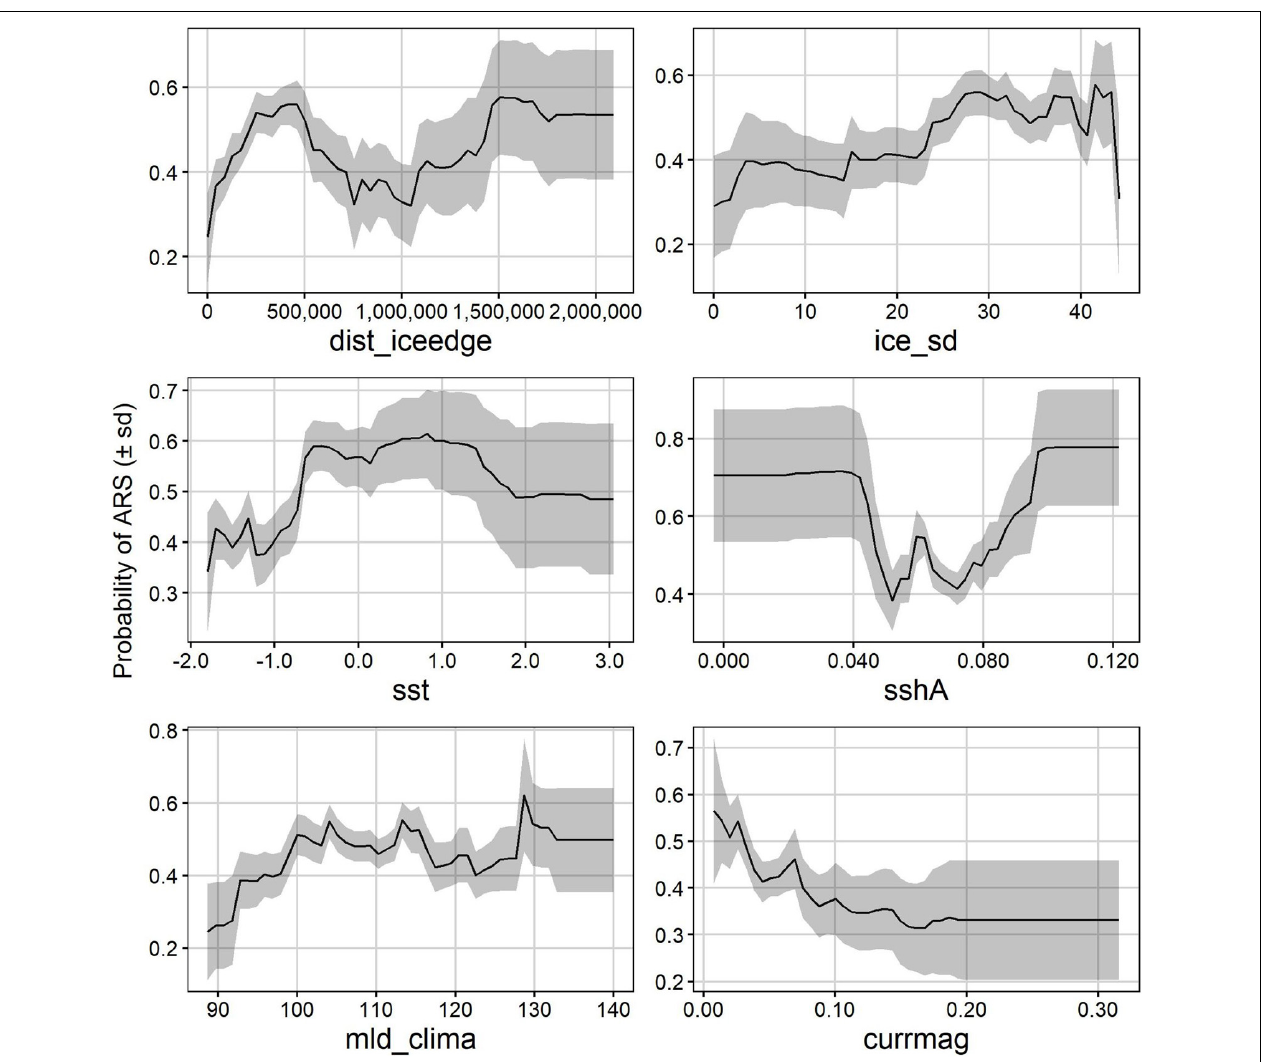
FIGURE 6 | Winter partial dependence plots showing how the probability of area restricted search (ARS) is influenced by the top six environmental variables in the winter models. Mean probability of ARS (solid line) ± sd (grey shaded) across the 500 bootstraps are shown. dist_iceedge, distance from the ice edge (m); ice_sd, ice concentration standard deviation; mld_clima, mixed layer depth climatology (m); sst, sea surface temperature ( ◦ C); sshA, sea surface height anomaly; currmag, current magnitude (m.s − 1